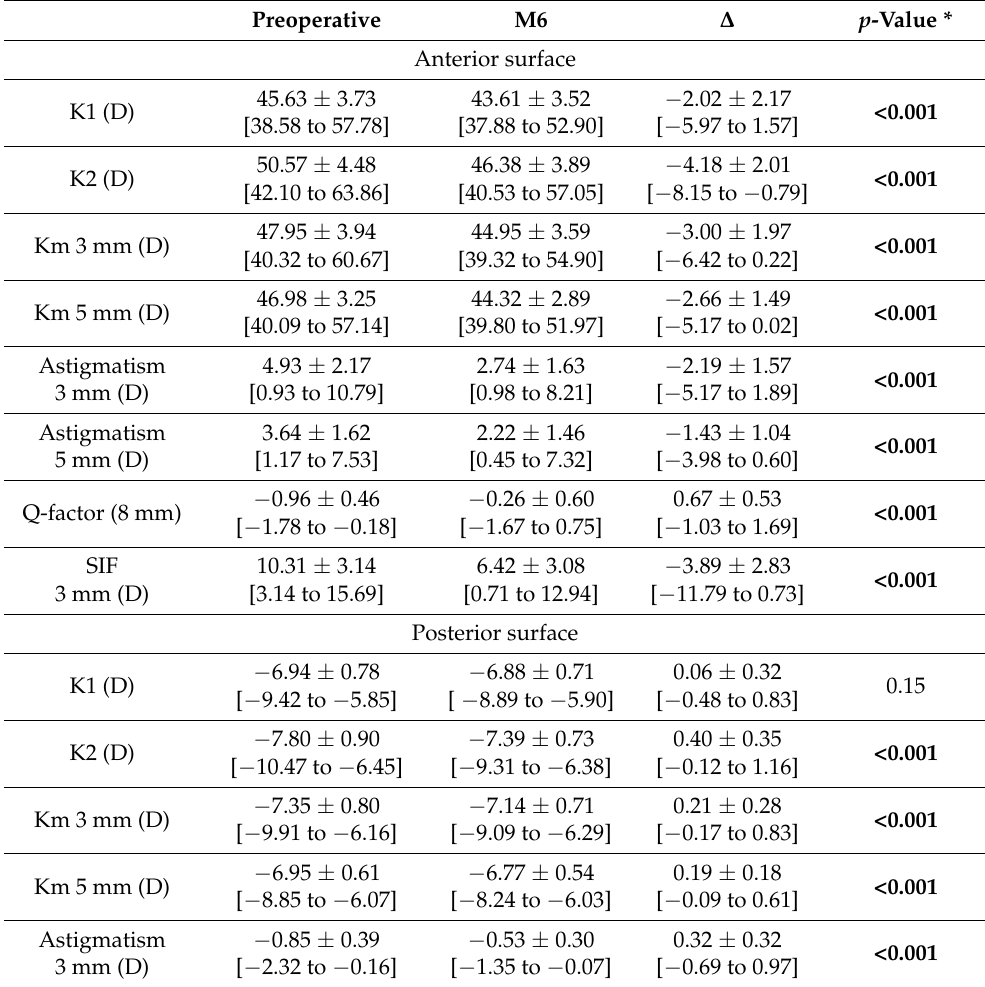
Table 4. Keratometry and asphericity results ( n =